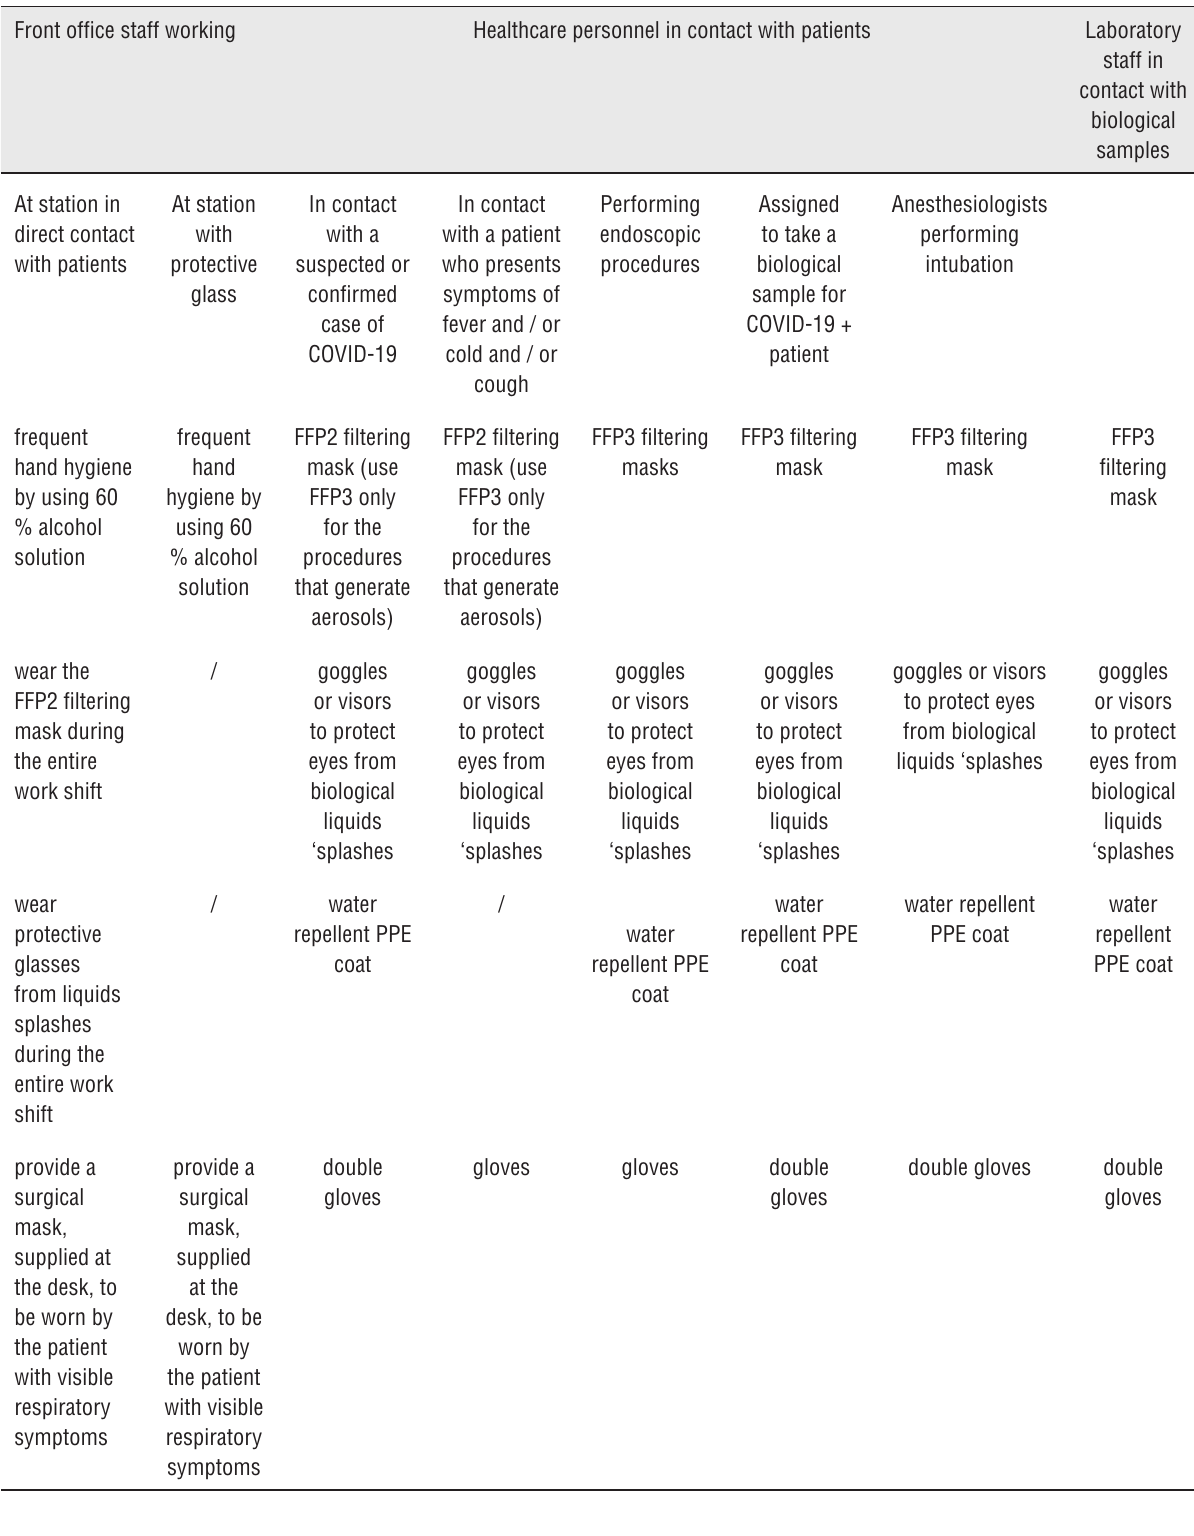
Table 2 - Summary of the COVID-19 task force actions regarding PPE of Health workers